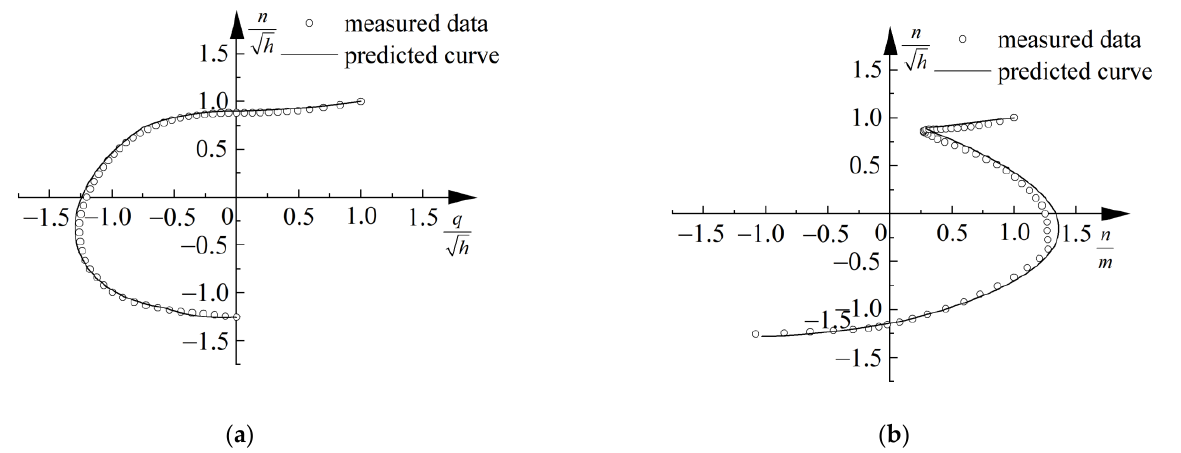
√ √ h − n / h curve and √ h curve and measured data.